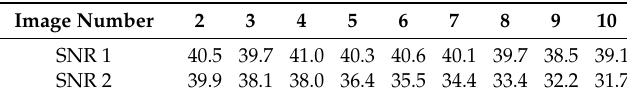
Table 2. Registration results. The row of SNR 1 lists the registration results with both geometric and photometric registration, and the row of SNR 2 lists the registration results with only geometric registration.